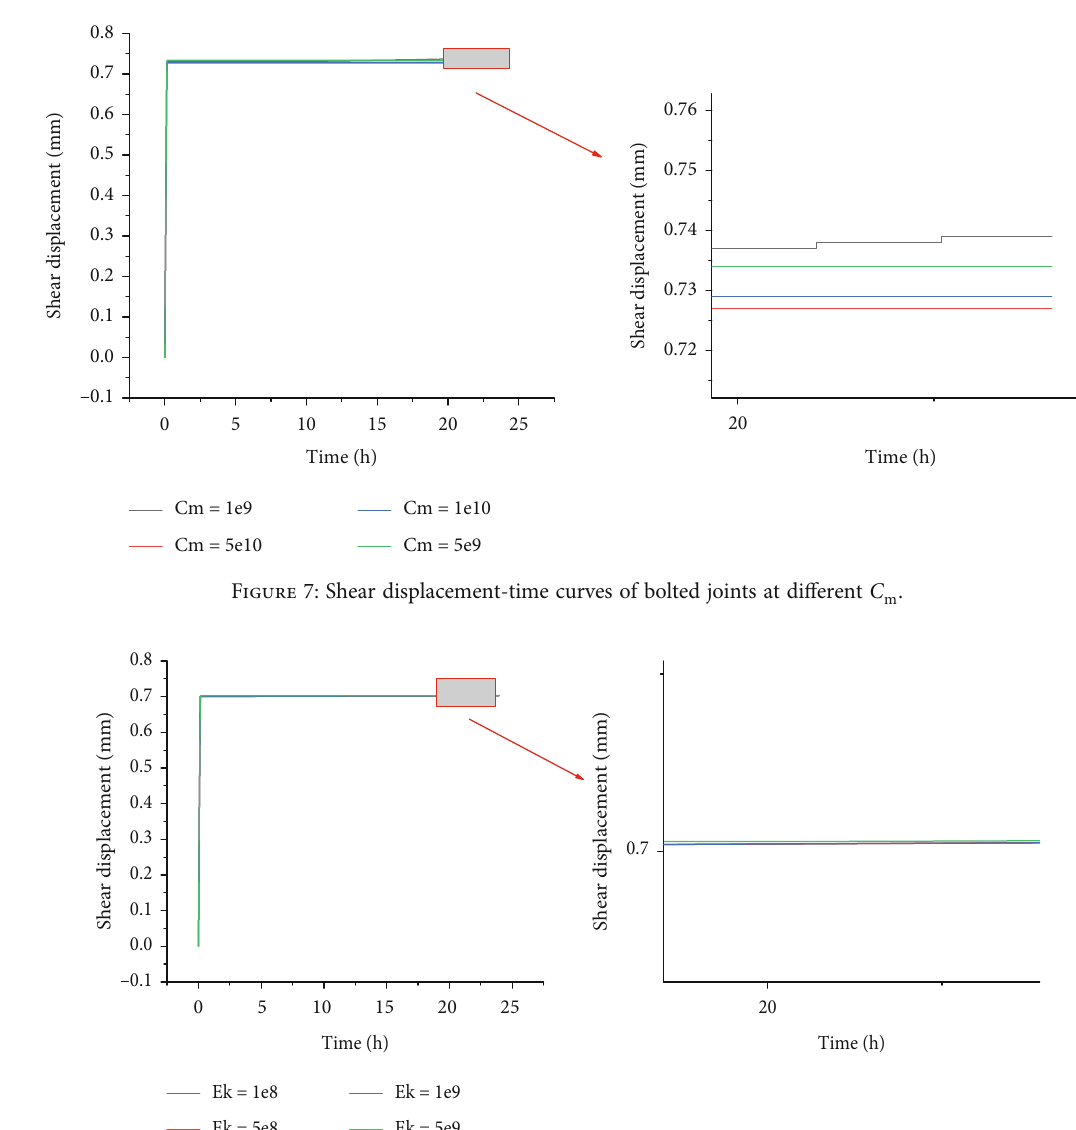
k conditions without